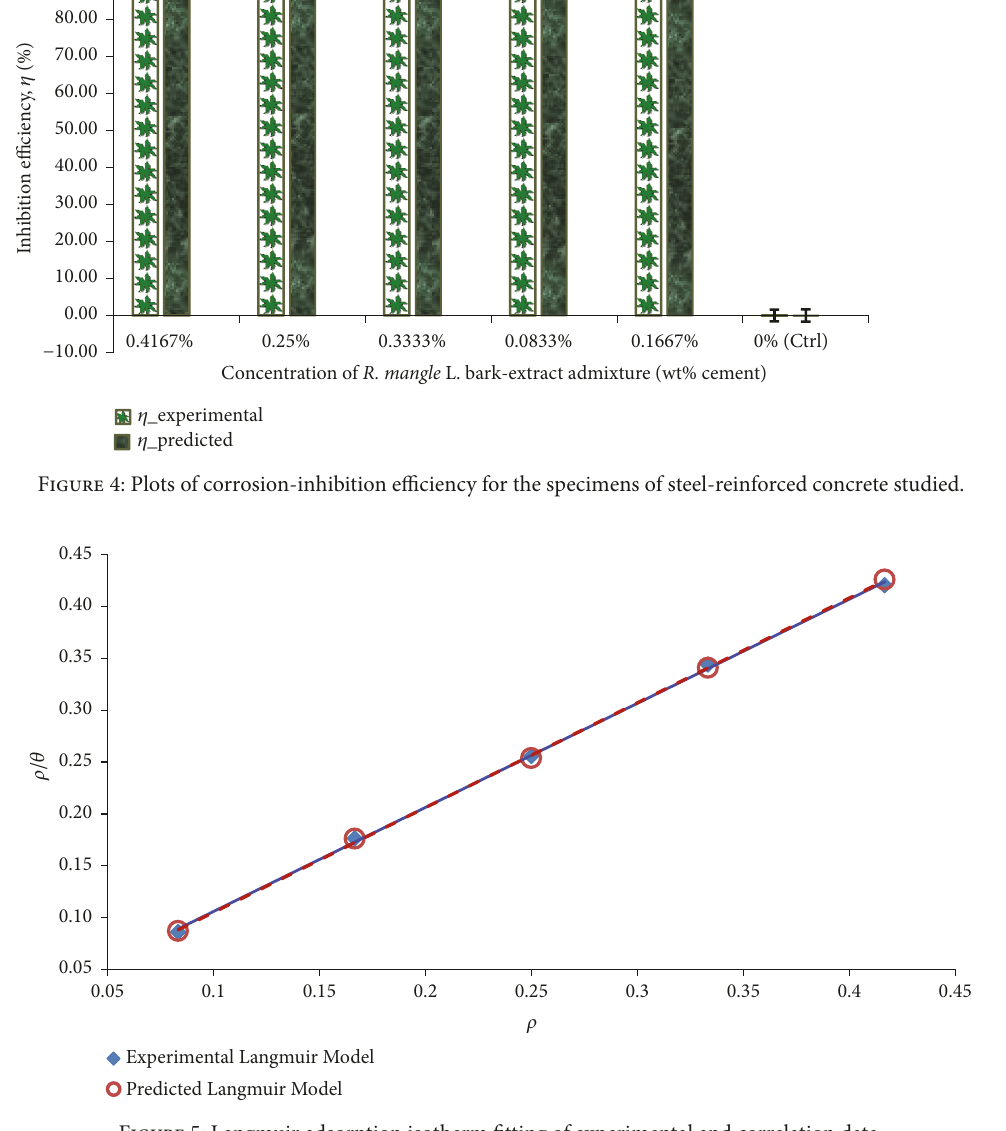
Figure 5: Langmuir adsorption isotherm fitting of experimental and correlation